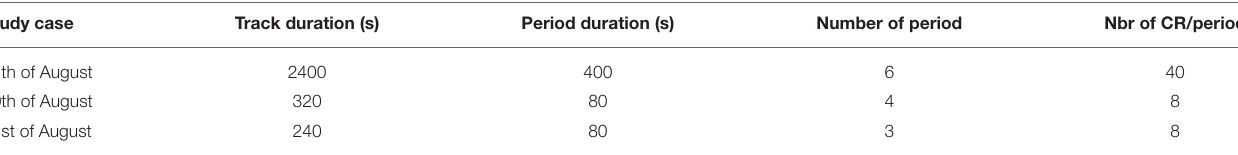
TABLE 1 | Table of the three case studies summarizing the parameters chosen to carry out the statistical tests. Study